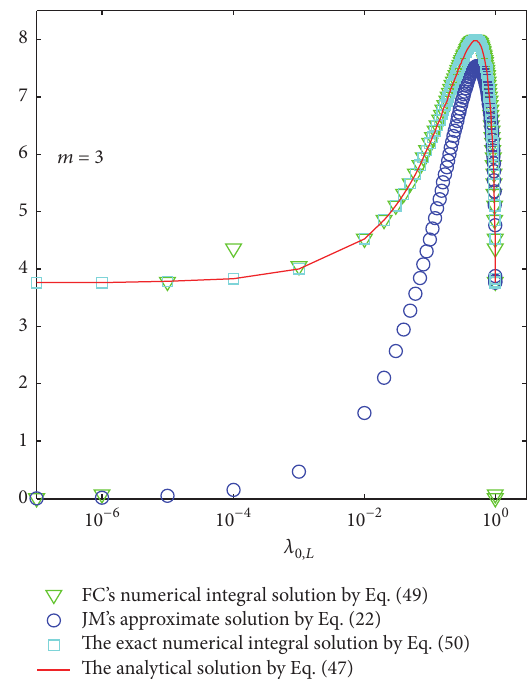
Figure 4: Comparison of different solutions for 𝑚 = 3 .